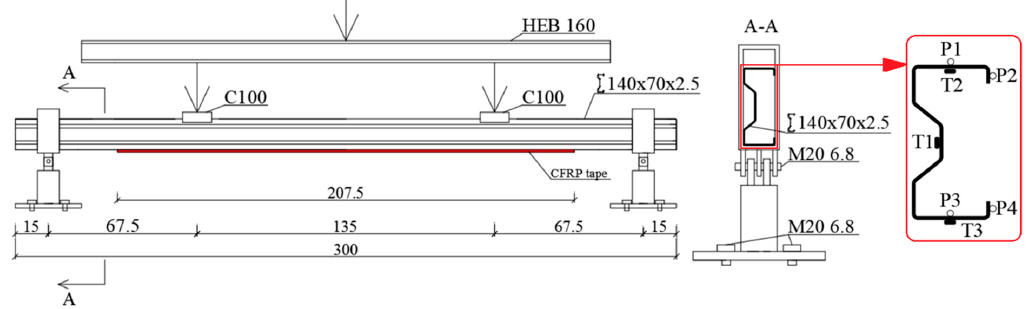
Figure 3. Laboratory stand scheme.